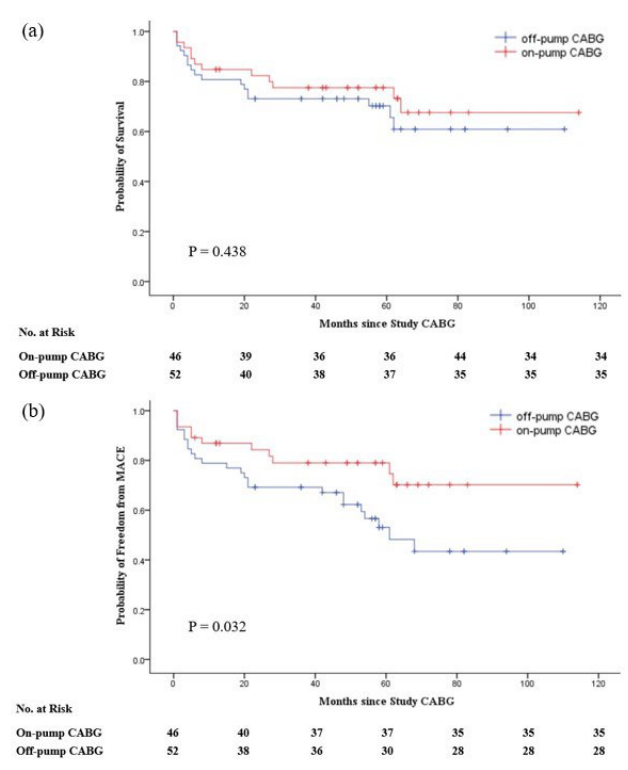
Figure 1. Kaplan–Meier estimates of rates of survival ( a ) and major adverse cardiovascular events (MACE) ( b ) before matched. Survival calculations were based on deaths from any cause. The composite MACE outcome was defined as death from any cause, nonfatal myocardial infarction, or repeat revascularization (CABG or PCI).